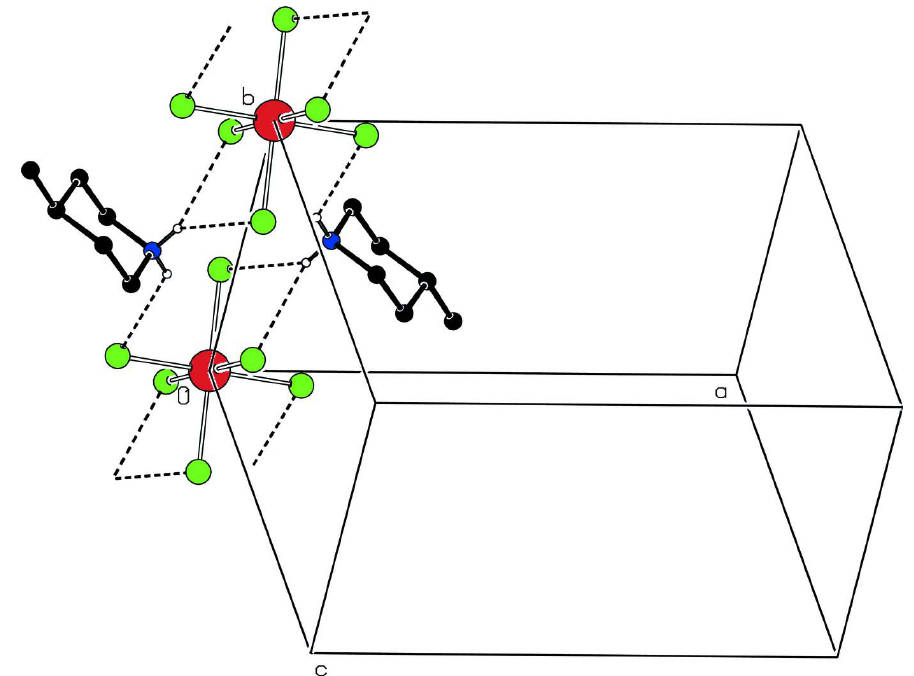
Figure 2 Fragment of the crystal packing of (I) showing chain along the b axis, viewed approximately along the diagonal of the bc - plane; H-bonds are shown as dashed